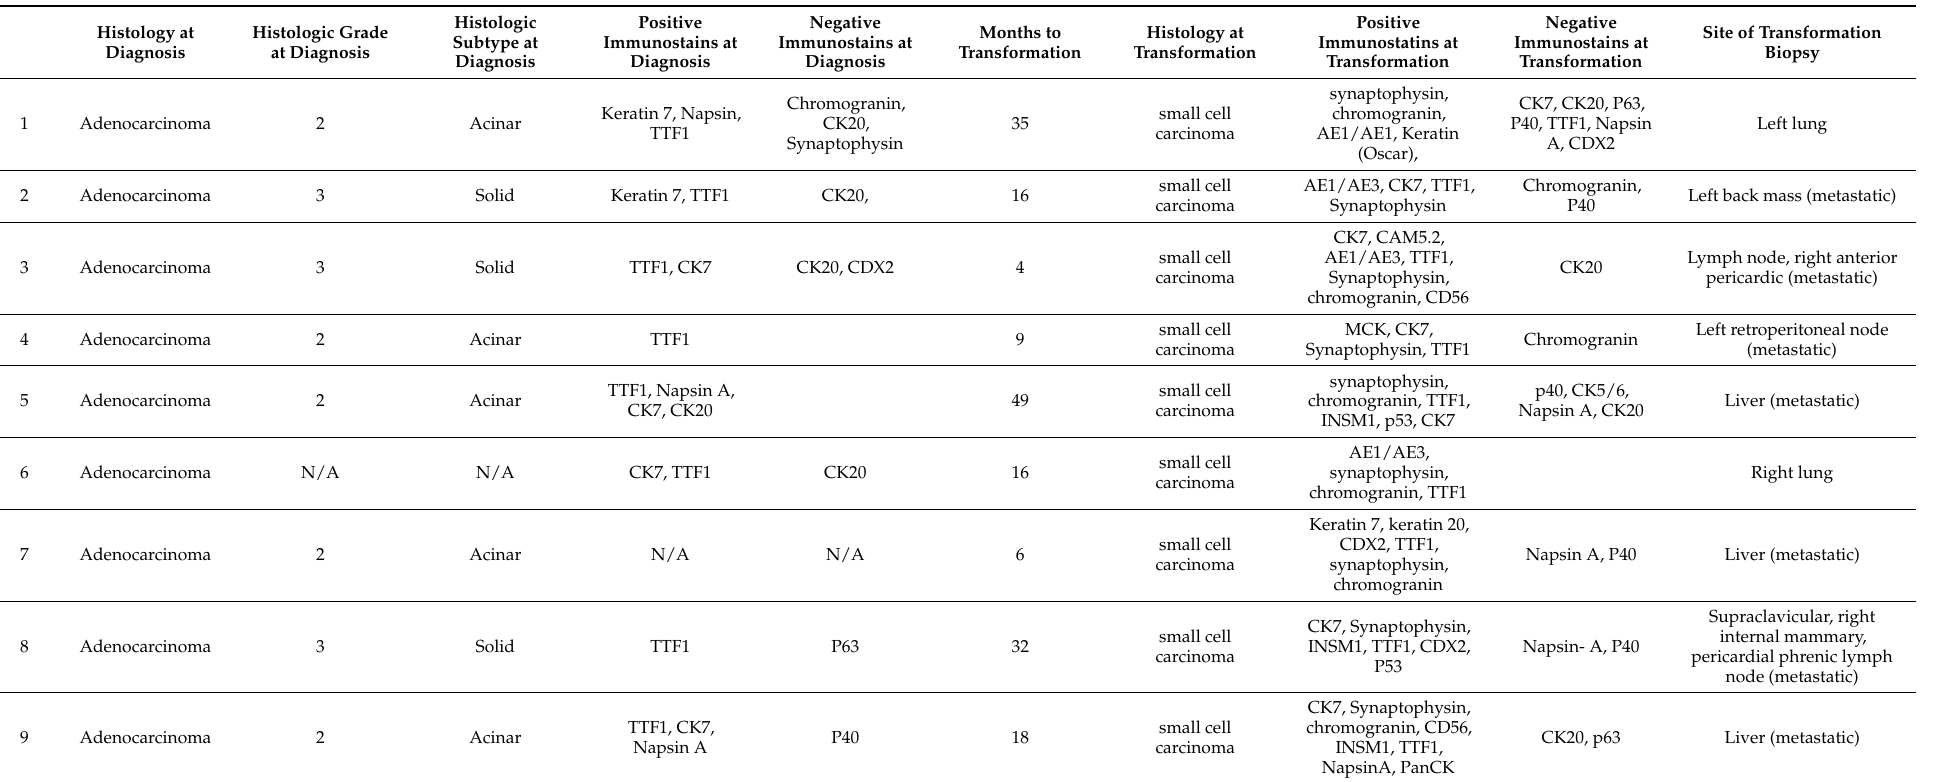
Table 3. Histological immunostains at diagnosis and upon